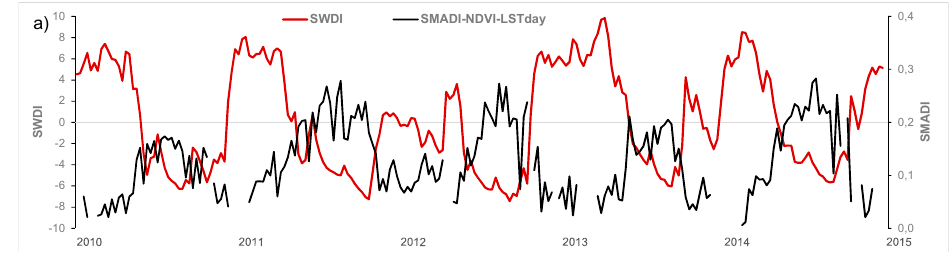
Figure 4. Cont. Figure 4.